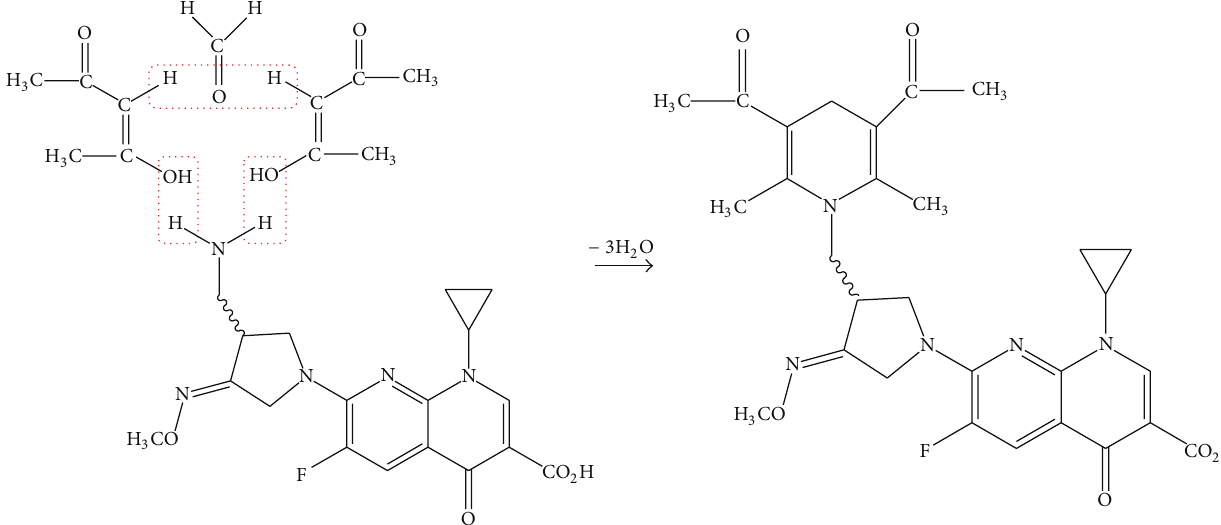
Scheme 2: The suggested mechanism for the Hantzsch reaction between gemifloxacin and acetylacetone-formaldehyde